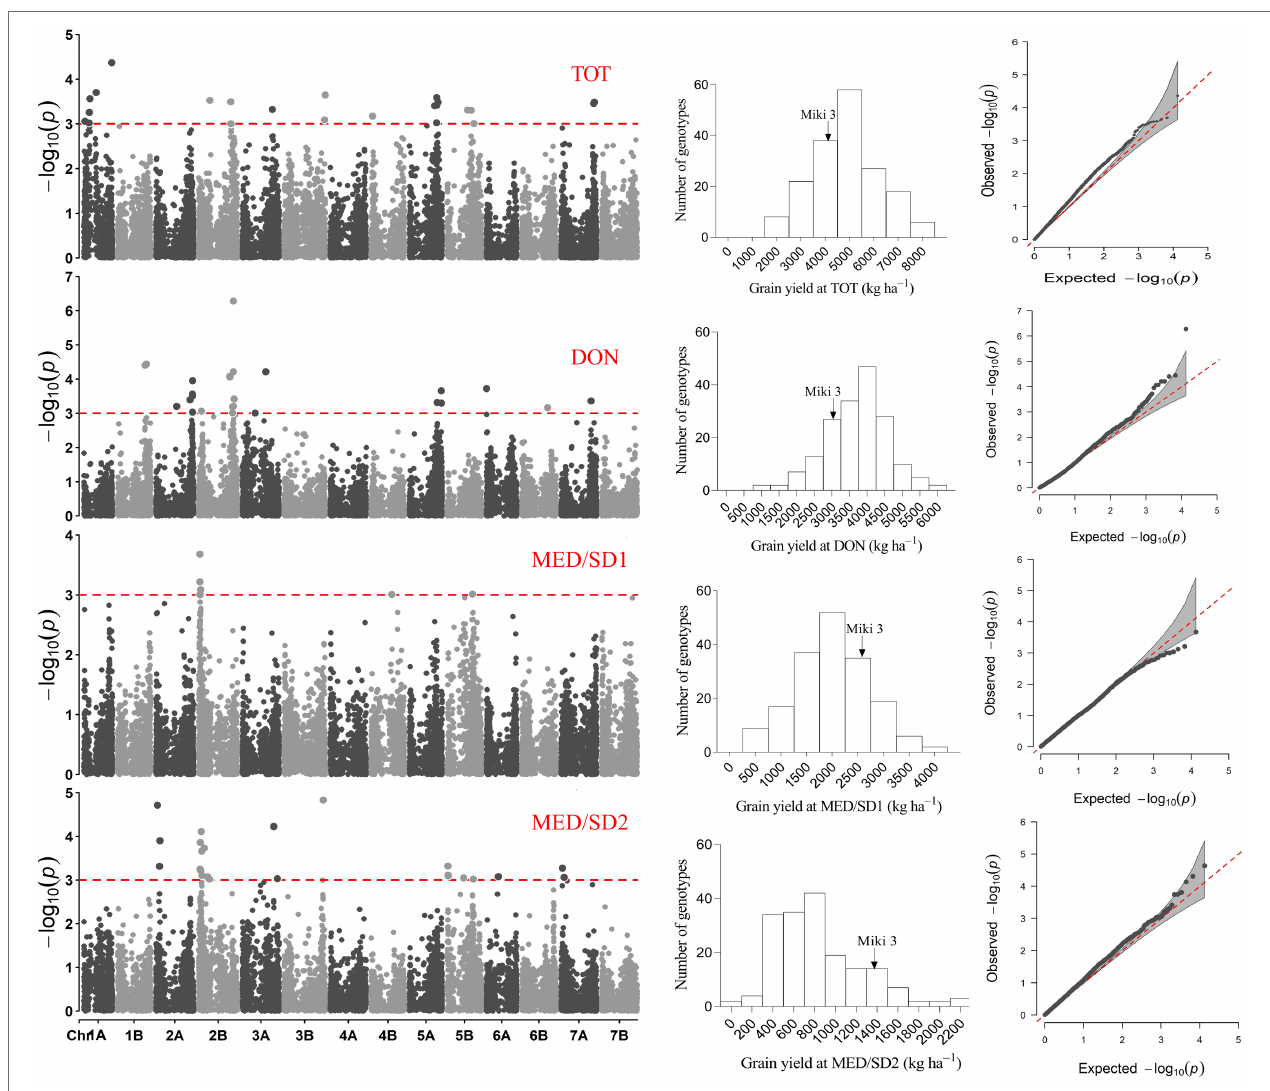
FIGURE 5 | Representative Manhattan plots for grain yield of the genome-wide analysis showing marker-trait association in the four environments; Tottori (TOT), Dongola (DON), Wad Medani first sowing date (MED/SD1) and Wad Medani second sowing date (MED/SD2). Frequency distributions and quantile − quantile plots for grain yield are shown for each